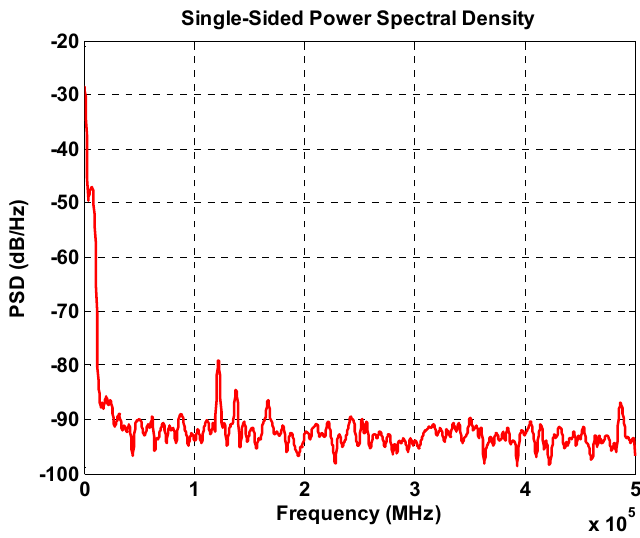
Figure 13. The power spectral density of the PGA output.